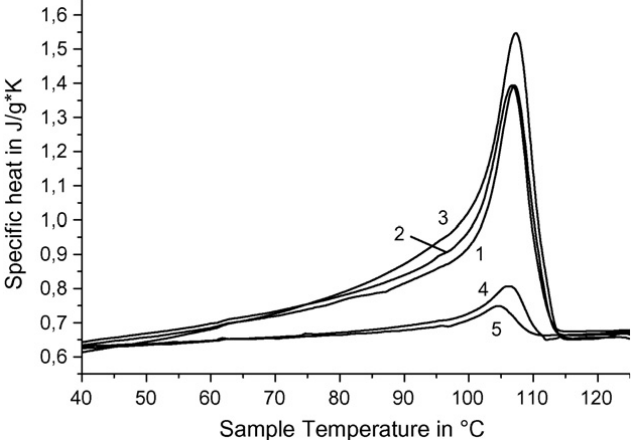
) and with different ratios of ceramics: RPE. T o Ba Cu O :RPE = 90:10 (1–3), 97:3 (4), 1 2 3 6.97